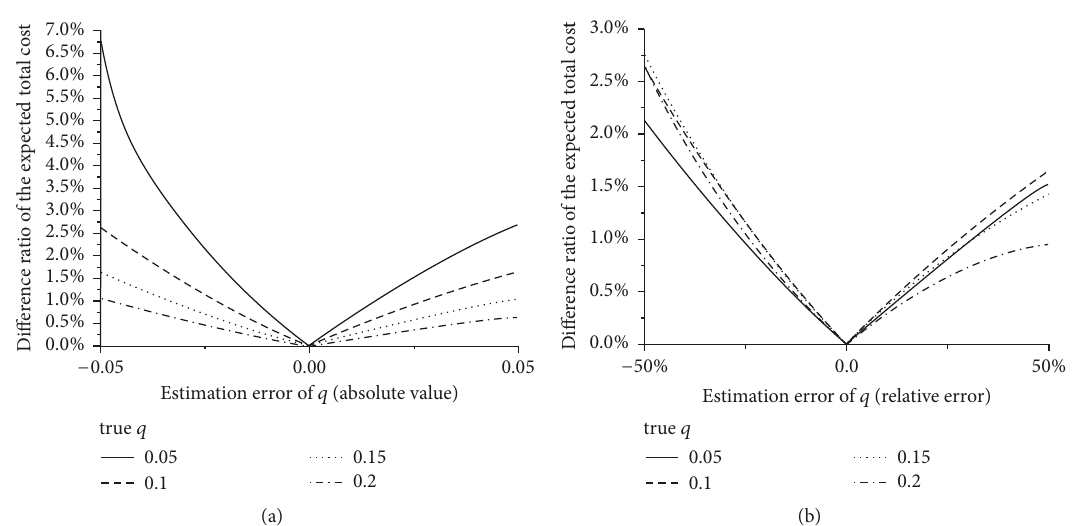
Figure 6: (a) The estimation error of q and the difference ratio of the expected total cost (absolute error); (b) the estimation error of q and the difference ratio of the expected total cost (relative